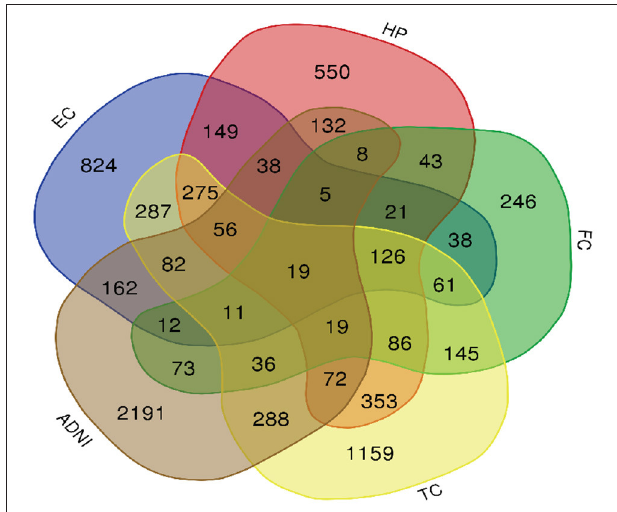
FIGURE 3 | Venn diagram is used to represent relationships between EC (blue), HP (red), FC (green), TC (yellow) and ADNI (brown).